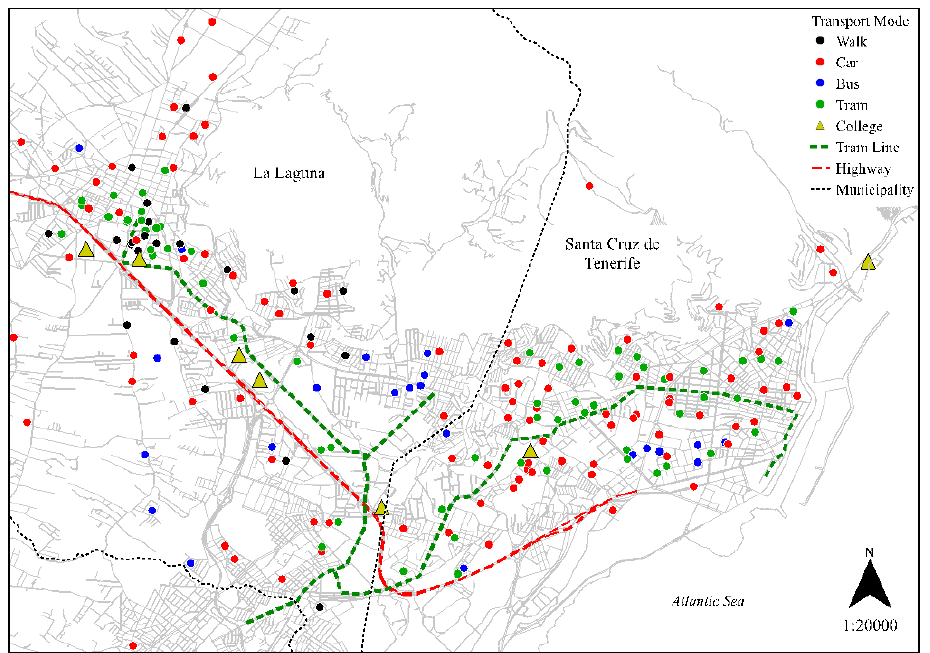
Figure 3. Revealed Preferences after tram implementation